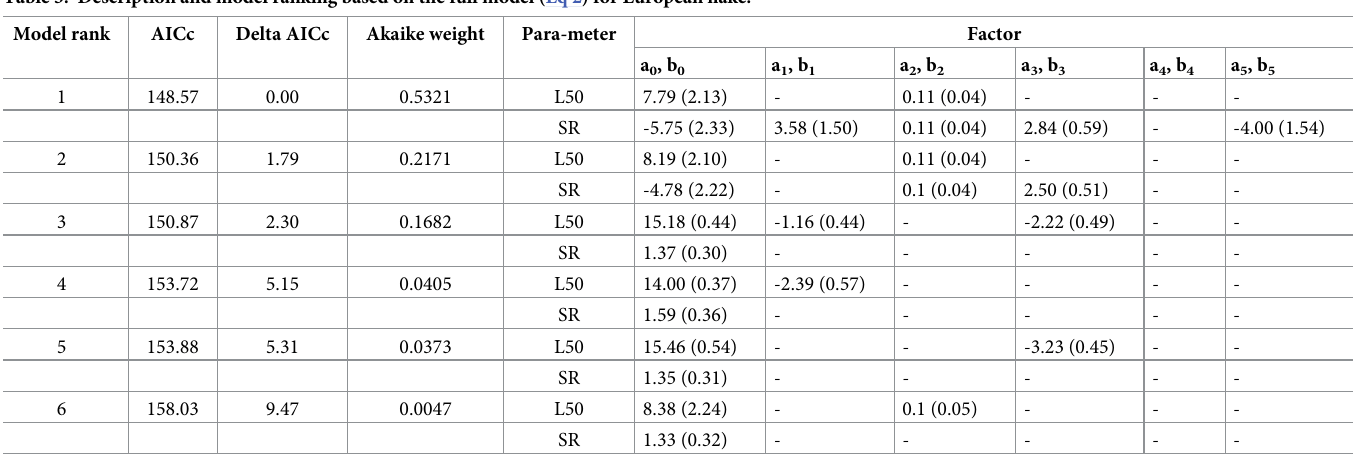
Table 5. Description and model ranking based on the full model (Eq 2) for European hake. Model